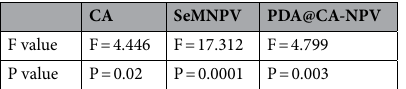
Table 3. DNA release content with sampling time subjected to